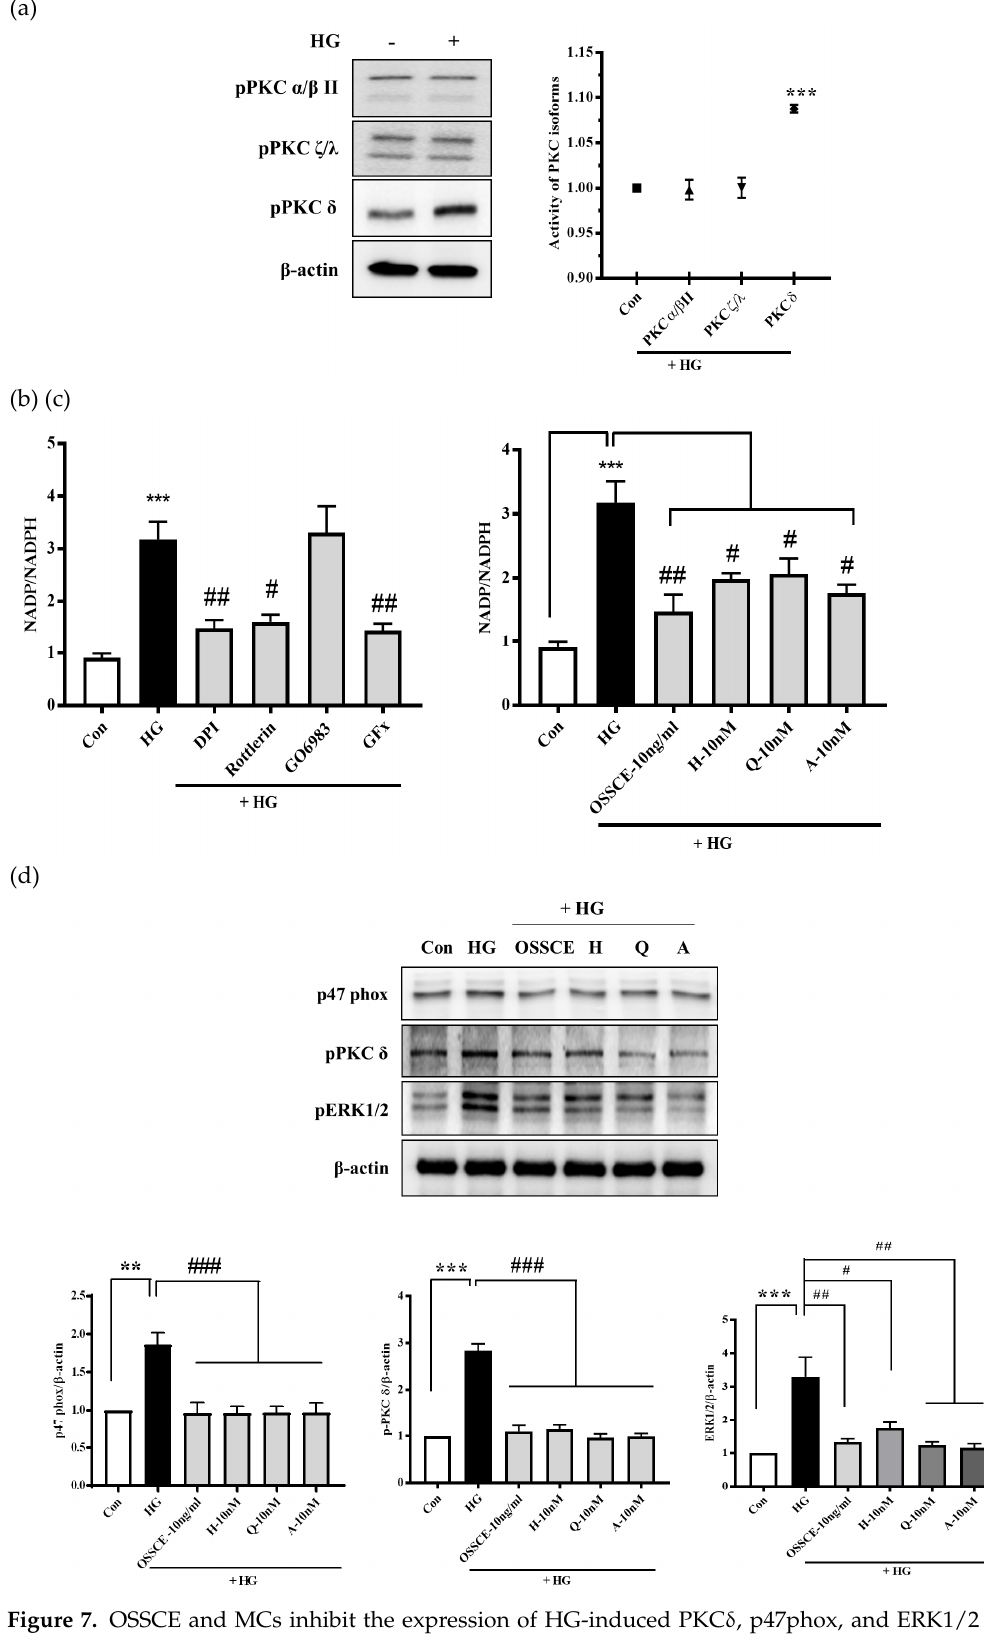
Figure 7. OSSCE and MCs inhibit the expression of HG-induced PKC δ , p47phox, and ERK1/2 in HRMECs. ( a ) The activity of PKC isoforms was evaluated. Only PKC δ was activated under